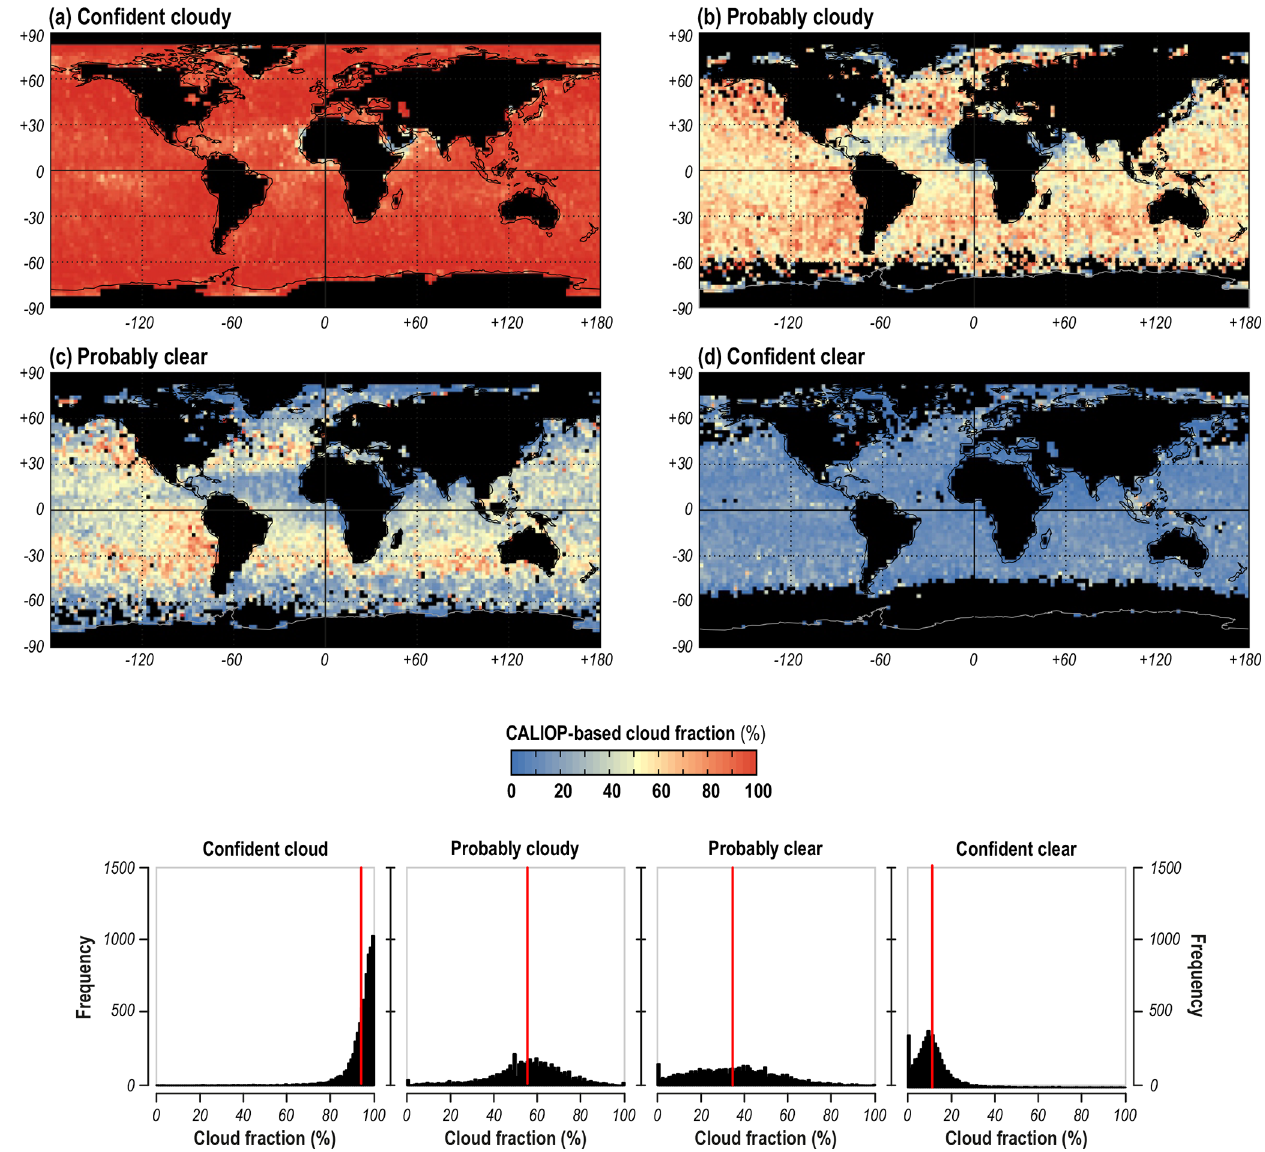
Figure 7. CALIOP-based cloud fraction for MODIS cloud mask classes for the “daytime, snow-free ocean” algorithm path and corresponding histograms (red vertical line indicates the mean